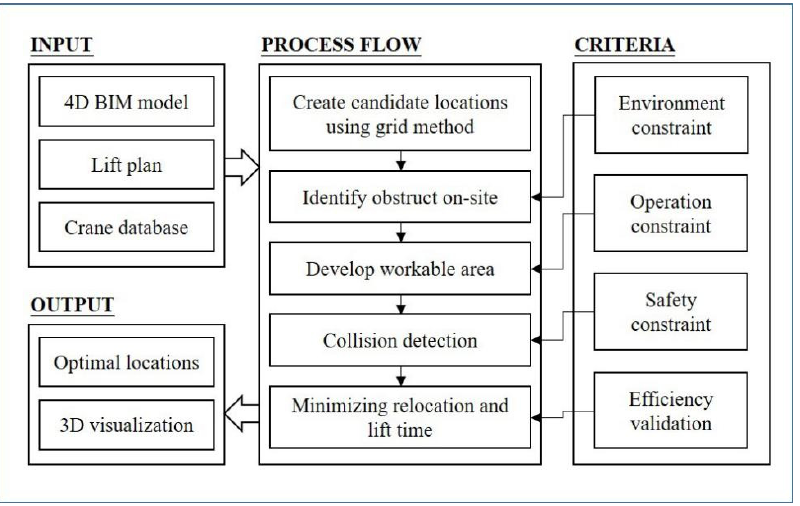
Figure 1. Logic framework of automated selection and localization of a mobile crane [42].